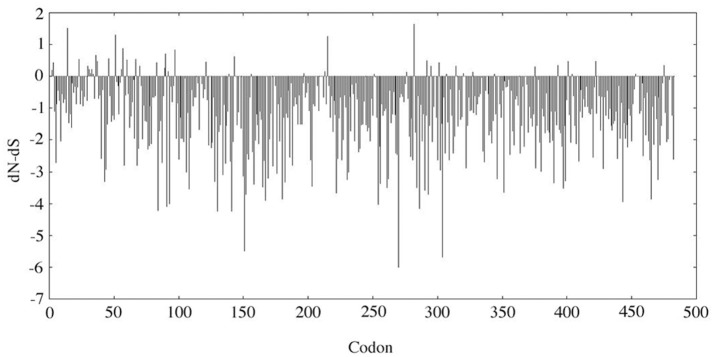
SLAC analysis. The dN-dS value was analyzed along the MMP20 codon sequence. dN, non-synonymous substitution rate; dS, synonymous substitution rate. When dN-dS < 0, the codon is subjected to purifying selection. When dN-dS > 0 (i.e., dN > dS), the codon is considered positively selected.